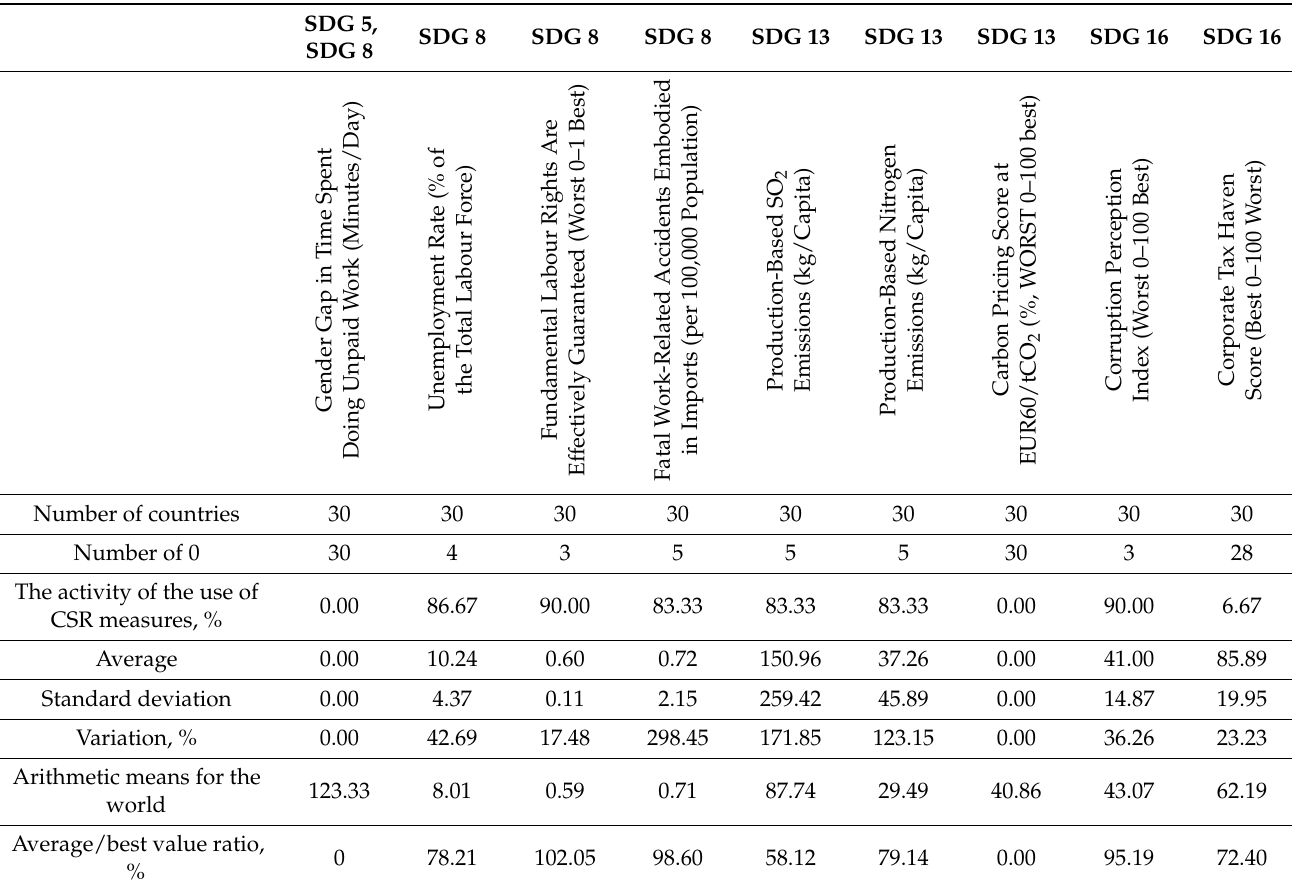
Table 7. Representation of the CSR practices to support the SDGs (UN standards) in countries of LAC in